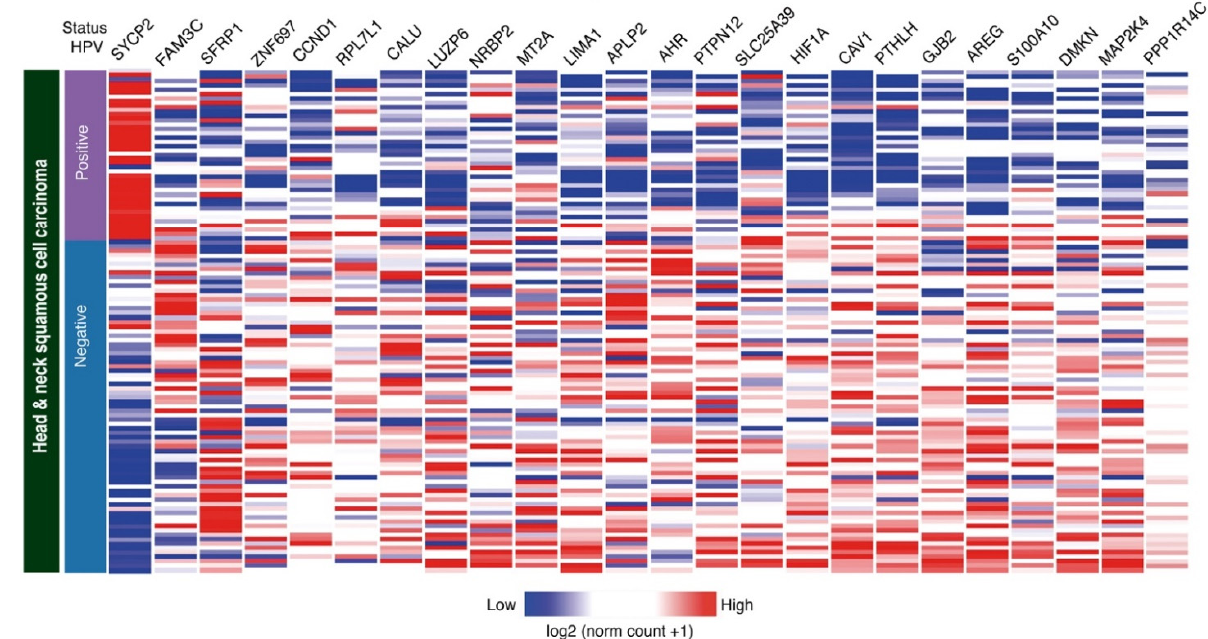
Figure 2. Transcriptome changes in HNSCC patients associated with presence or absence of HPV and p16. ( A ) Graph shows the classification of differentially expressed transcripts in HPV+/p16+ samples versus HPV − /p16 − samples in tissues with HNSCC. Main differentially expressed mRNAs ( B ) and lncRNAs ( C ) in HPV+/p16+ vs. HPV − /p16 − samples. ( D ) Heat map showing gene expression between HPV+ tissues ( n = 39) and HPV − tissues ( n = 75) in HNSCC patients. Columns show the expression of each transcript validated in TCGA samples. Gene expression is shown in a range from red (greater) to blue